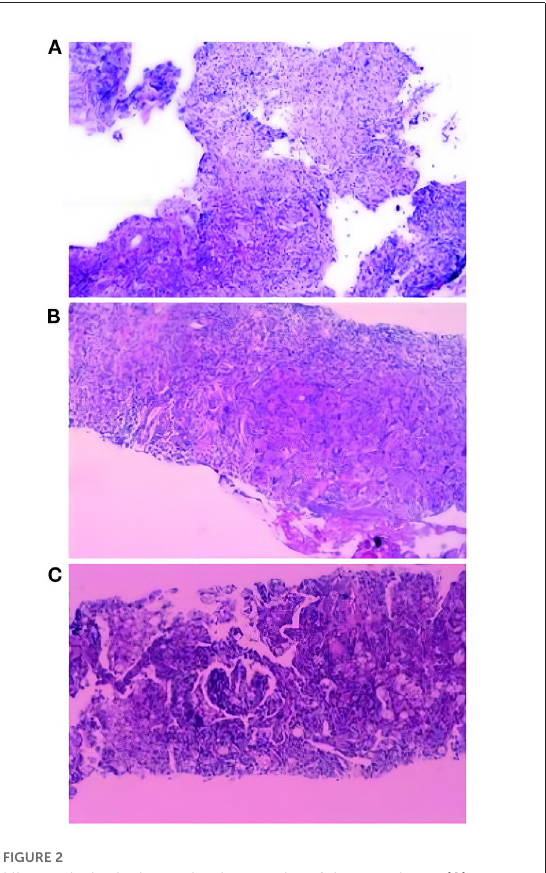
Histopathological examination results of three patients. (A) Granulomatous inflammation, with more spore-like material, Manifestations of fungal infection, tends to cryptococcus neoformans. Special staining: PAS ( + ), AFB (-), GMS ( + ). (B) Lung tissue chronic inflammation, local multinucleated giant cells, intracellular spore-like structure, Special staining: PAS ( + ), AFB (-), GMS ( + ). Combining the results of the special stain and the clinical features of the patient, the patient was considered to have a cryptococcal infection of the lung. (C) Combined with the morphology and special staining results, Tendency to fungal infections: Cryptococcus and Talaromyces marneffei infection. Pneumocystis Pneumocystis jirovecii infection cannot be ruled out. Special dyeing: Mucus red card ( + ), GMS ( + ), PAS ( +